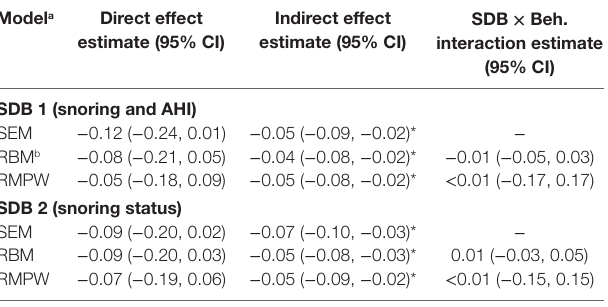
TaBle 2 | Estimates of direct and indirect effects of sleep-disordered breathing (SDB) on cognition. Model